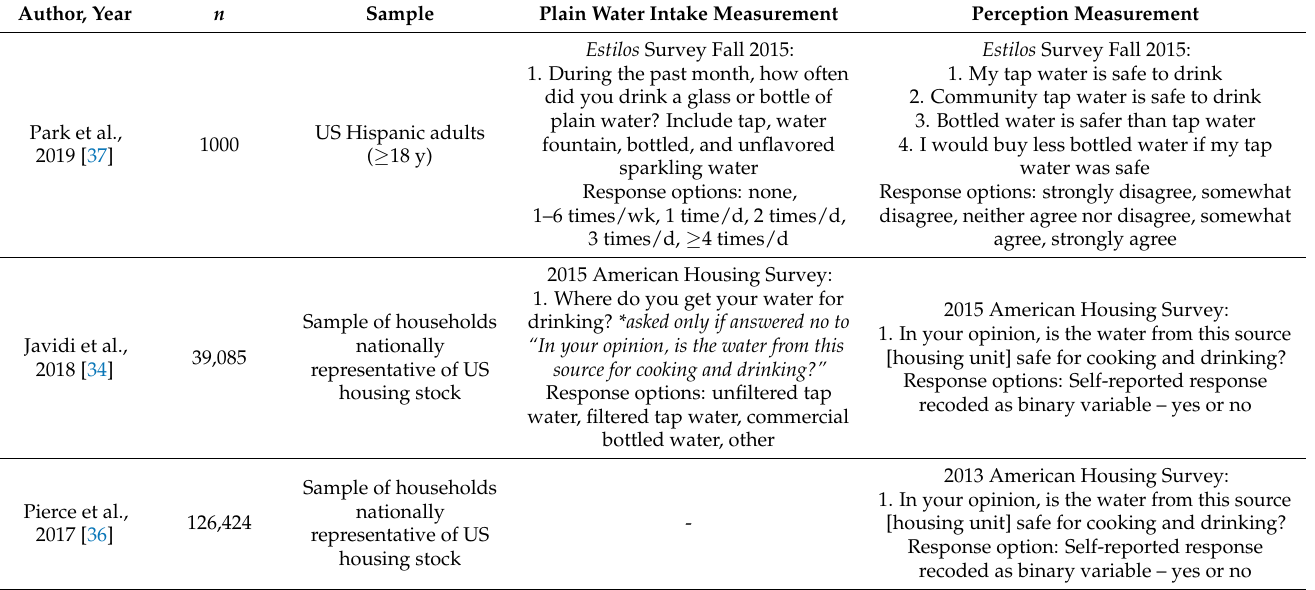
Table 3. Investigational approaches to measuring plain water intake and